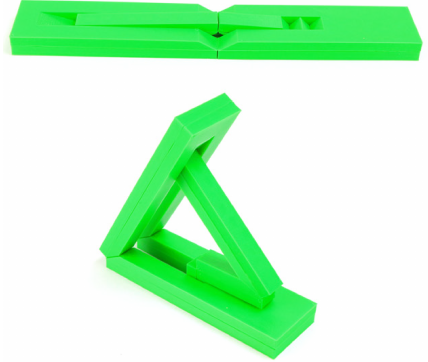
Figure 15. Diagram of a planar deploying strut ThUDS with offset crease joint added to depict key parameters, excluding d 1 − d 5 (see Fig. 2). Dashed lines designate joint reference planes.